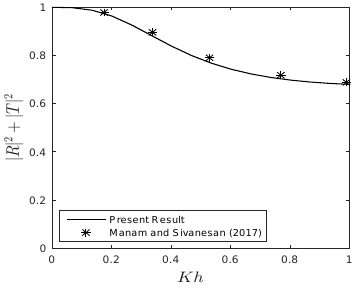
Figure 3. | R | 2 + | T | 2 vs. dimensionless wavenumber Kh with µ 1 = 1 . 8 and G = 0 . 5